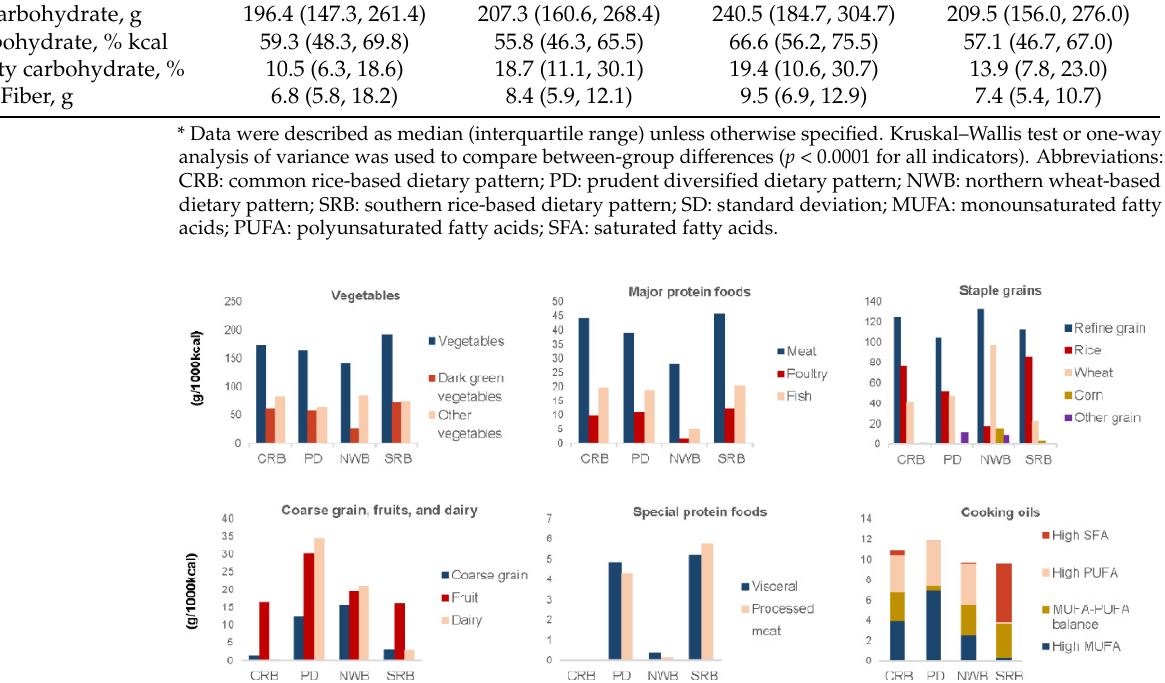
Figure 3. Mean intakes of selected food groups for four dietary patterns. Intake was calculated as